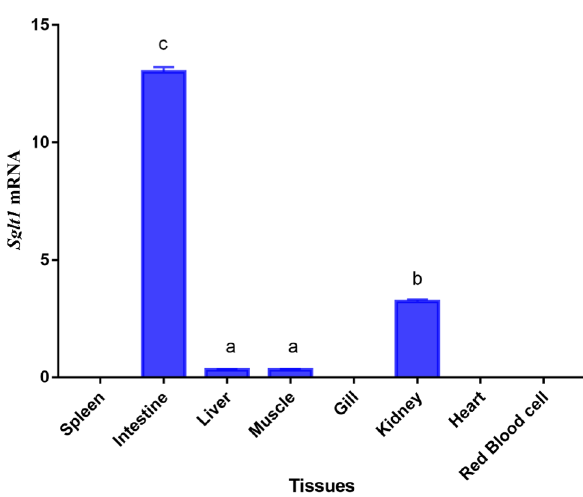
Figure 5. Tissue-specific mRNA expressions of sglt1 in Megalobrama amblycephala . Vertical bars represent mean ± SE values for triplicate samples.